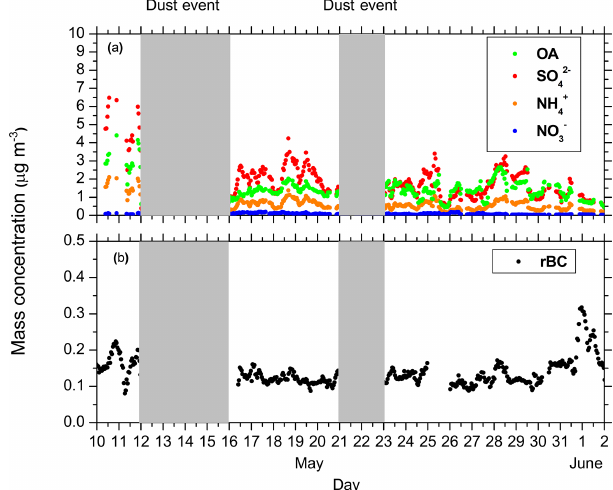
Figure 1. Evolution of the aerosol chemical composition based on the high-resolution aerosol mass spectrometer (HR-ToF-AMS) and single particle soot photometer (SP2) measurements during FAME- 16. (a) The nonrefractory aerosol components and (b) refractory black carbon (rBC) concentration. The shaded areas represent the dust event periods.